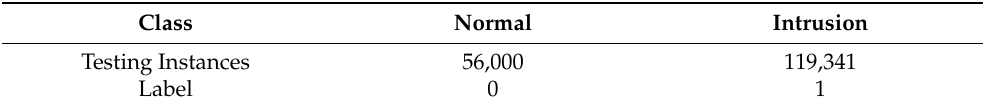
Table 3. Testing